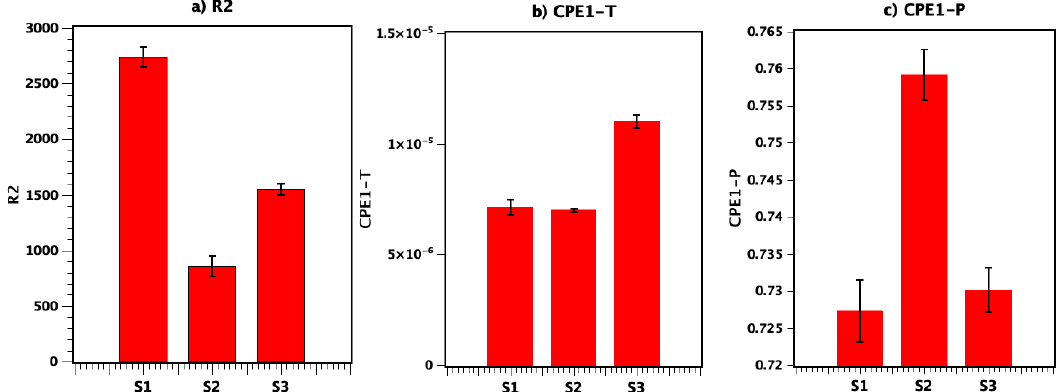
Figure 7. R2, CPE-T and CPE-P for S1, S2, and S3 (error bar marked on the graph representing standard deviation).